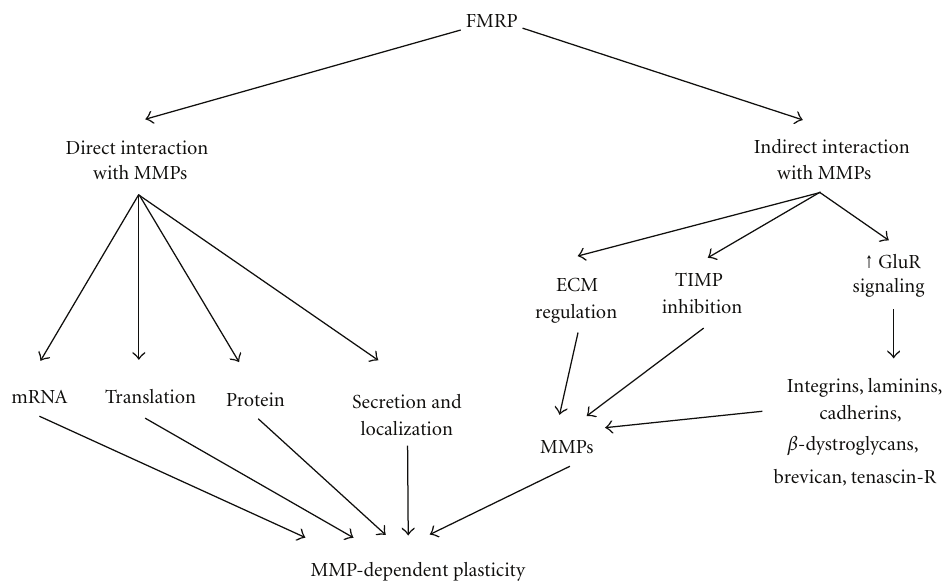
Figure 1: Schematic of potential interaction mechanisms between FMRP and MMPs. FMRP may more directly regulate MMPs at the level of transcript stability, translation, or protein function. FMRP may more indirectly convergently interact with MMPs in the regulation of extracellular matrix (ECM) components and their receptors, via the endogenous TIMP regulatory mechanism, or via glutamate receptor (GluR)